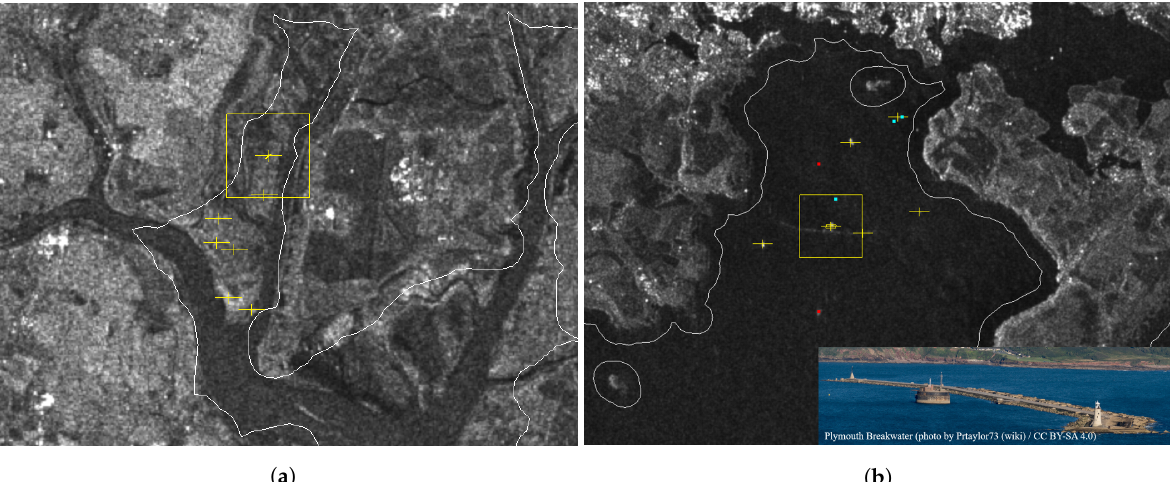
Figure 9. English Channel SUMO false alarm examples: ( a ) imperfect land mask; ( b ) coastal infrastructure (yellow box) and azimuth ambiguities (red